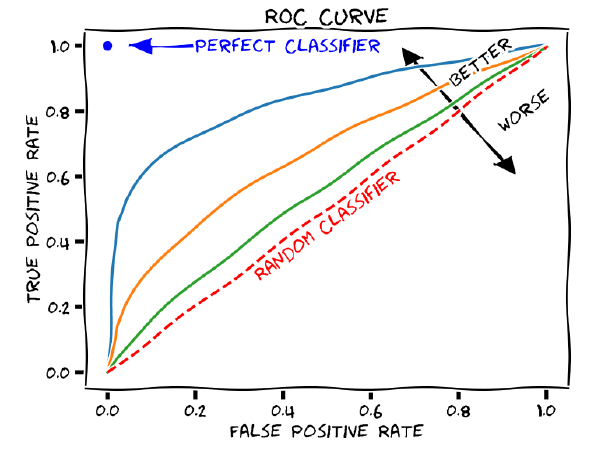
Figure 10. ROC curve description [40].